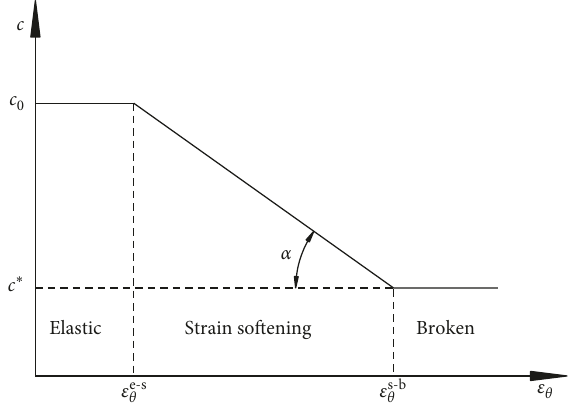
Figure 5: Softening model of the strength parameter.